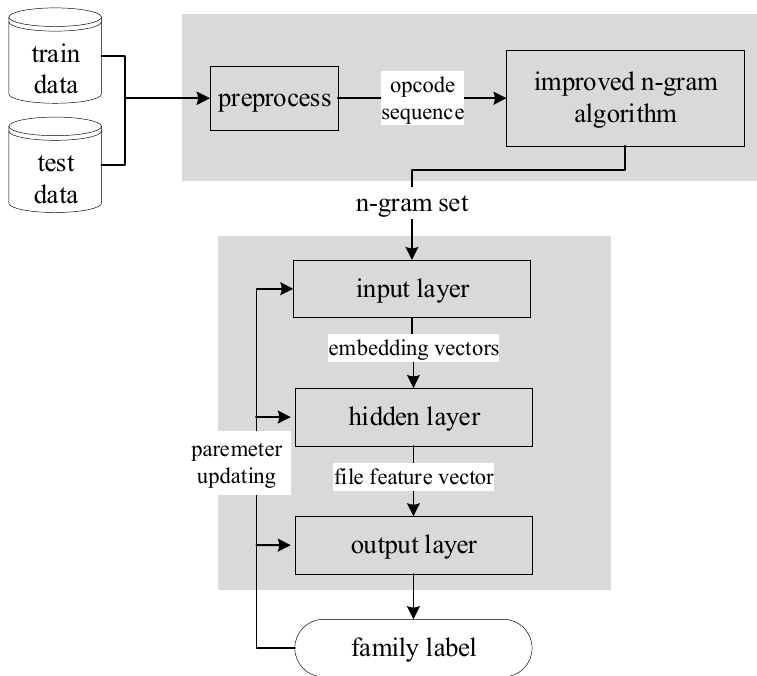
Figure 1. The working process of the shallow neural network-based malware classifier (SNNMAC).